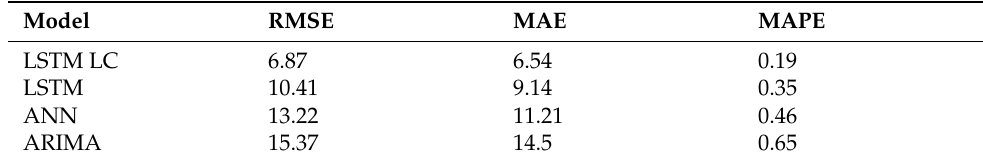
Table 5. Model results